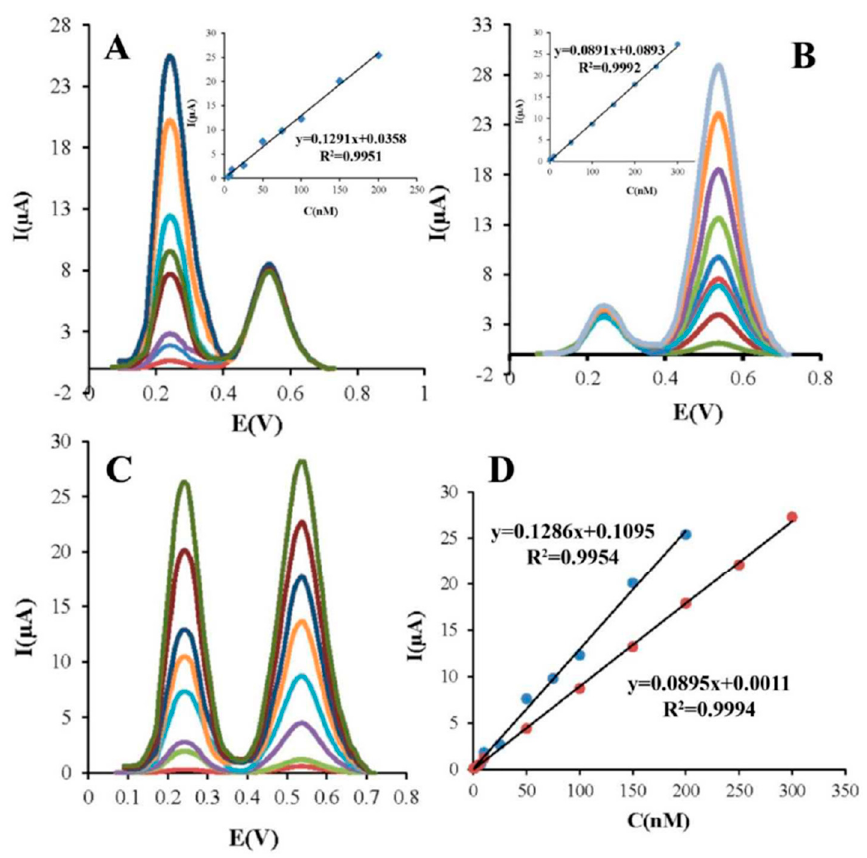
Figure 4. DPV results for ( A ) The solution containing an increasing concentration of carbofuran (CBF) (current peak at +0.23 V) in the range from 5.0 to 200.0 nM and a constant concentration of 100 nM of carbaryl (current peak at +0.51 V), ( B ) The solution with variable concentrations of carbaryl from 1.0 to 300 nM, and a constant concentration of CBF, ( C ) The solution containing a variable concentration of both pesticides and ( D ) The corresponding linear concentration ranges for both pesticides. All measurements were performed using MIL(Fe)101-rGO-modified GCE in the B-R buffer solution. Reprinted with permission from Ref. [66]. Copyright 2019 Wiley-VCH Verlag GmbH & Co. KGaA.